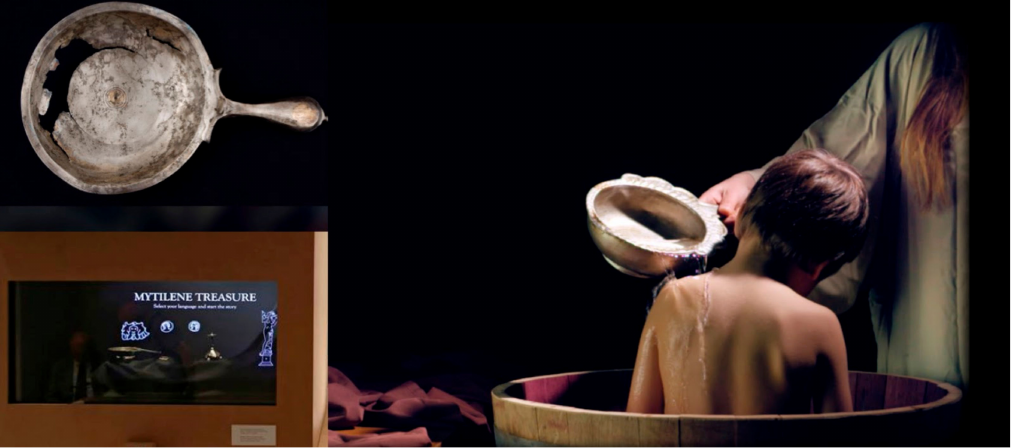
Figure 8. The trulla of the Byzantine treasure exhibited in the holographic showcase. It has been digitally restored and printed in 3D; the replica has been used in an animation showing its